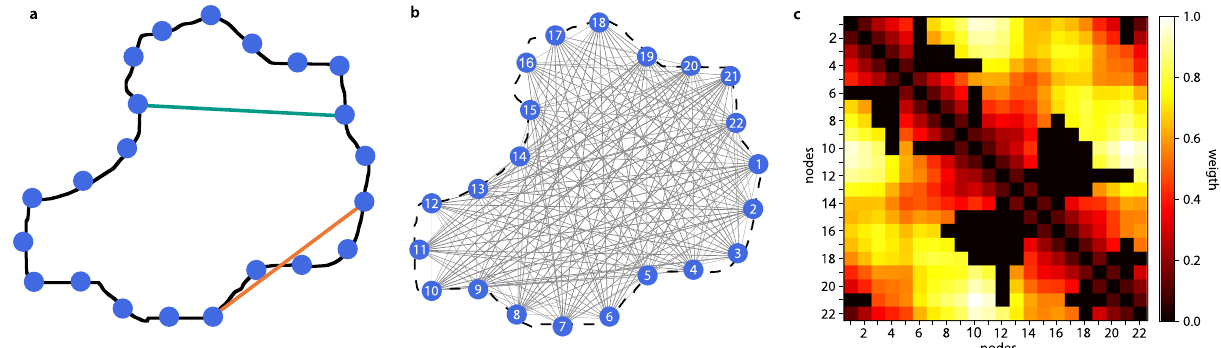
Fig. 1 Visibility graphs as a descriptor of shape. a Contour of an illustrative shape. Nodes (blue) are placed equidistantly along the contour and used to create a visibility graph. Two nodes are connected in the visibility graph if they can “ see each other ” , i.e., the segment connecting them does not cross or align with the contour (teal edge); otherwise, the nodes cannot see each other (orange edge). The edges between nodes can be weighted according to their edge length (Euclidean distance d E ). b Visualization of the visibility graph for the cell in ( a ). c Heatmap of the weighted and scaled adjacency matrix of the visibility graph ( a ), where edges with a weight of zero indicate the absence of said edge, thus indicating “ non-visibility ” between the nodes. The weighted visibility graph is used for local feature extraction, while the unweighted graph is used for global shape description and shape comparison. Source data are provided as a Source Data